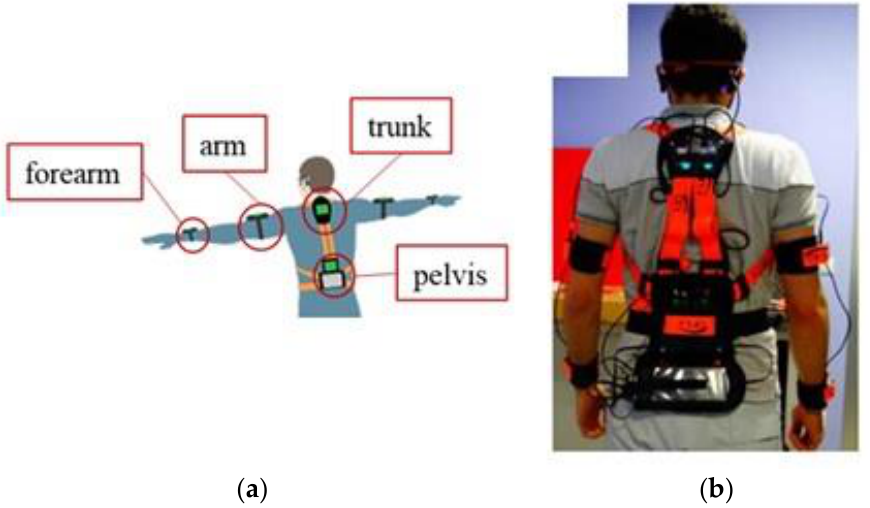
Figure 5. Wearable motion capture system, in upper-body configuration: ( a ) scheme; ( b ) equipped by the worker.